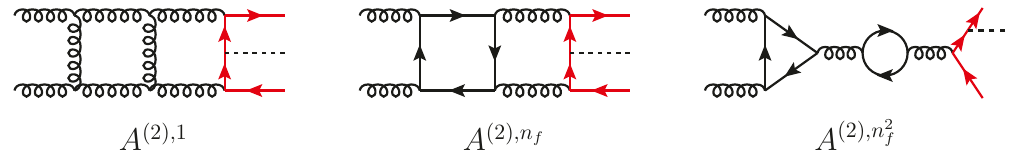
Figure 2. Sample Feynman diagrams corresponding to the various closed fermion loop contribu- tions at two loops as specified in eq. (2.9). Black-dashed, red, black-spiralled and black lines repre- sent Higgs bosons, bottom quarks, gluons and light quarks (bottom quarks included),